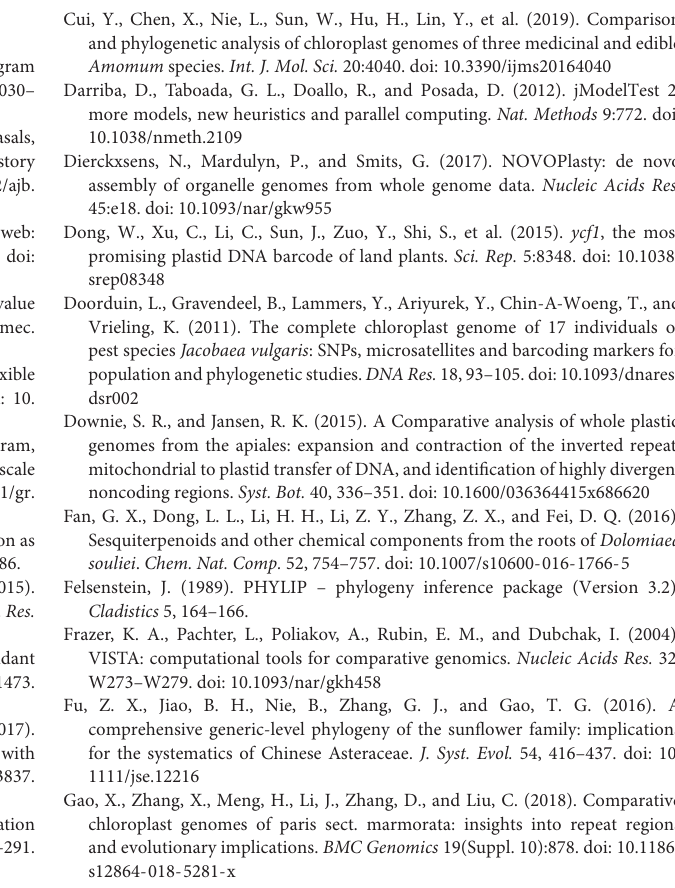
TABLE S3 | Phylogenetic informativeness profiles for 79 plastid protein-coding genes. Included are number of sites for which substitution rates were calculated (#Rates), net phylogenetic informativeness at epochs: 0–0.015 (Net PI) and per-site phylogenetic informativeness (Per-site PI). Ten genes with the most net informativeness are colored in